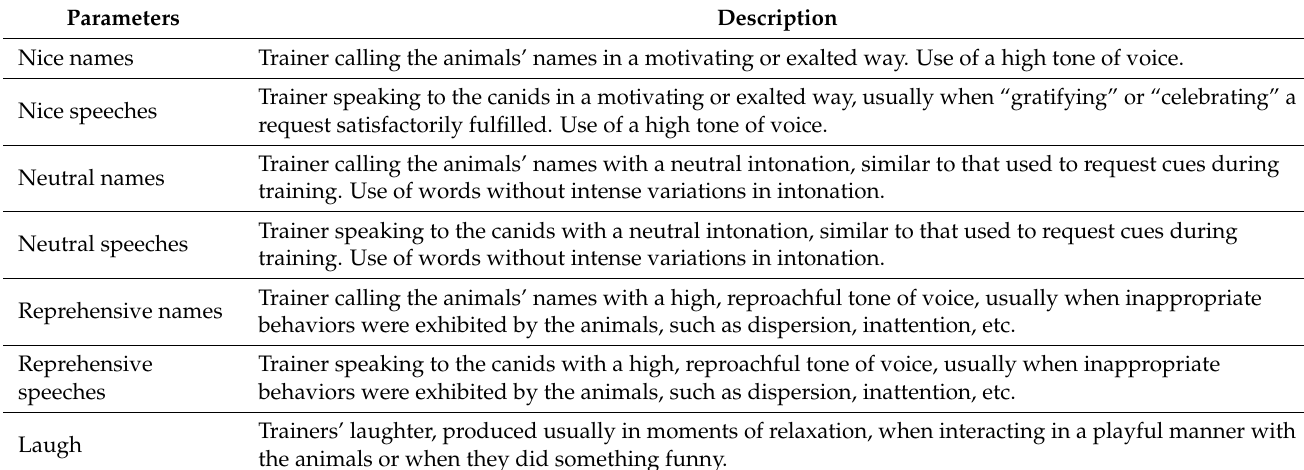
Table 2. Description of seven types of trainer vocalization, obtained for each training session with socialized dogs ( Canis familiaris ) and wolves ( Canis lupus ).